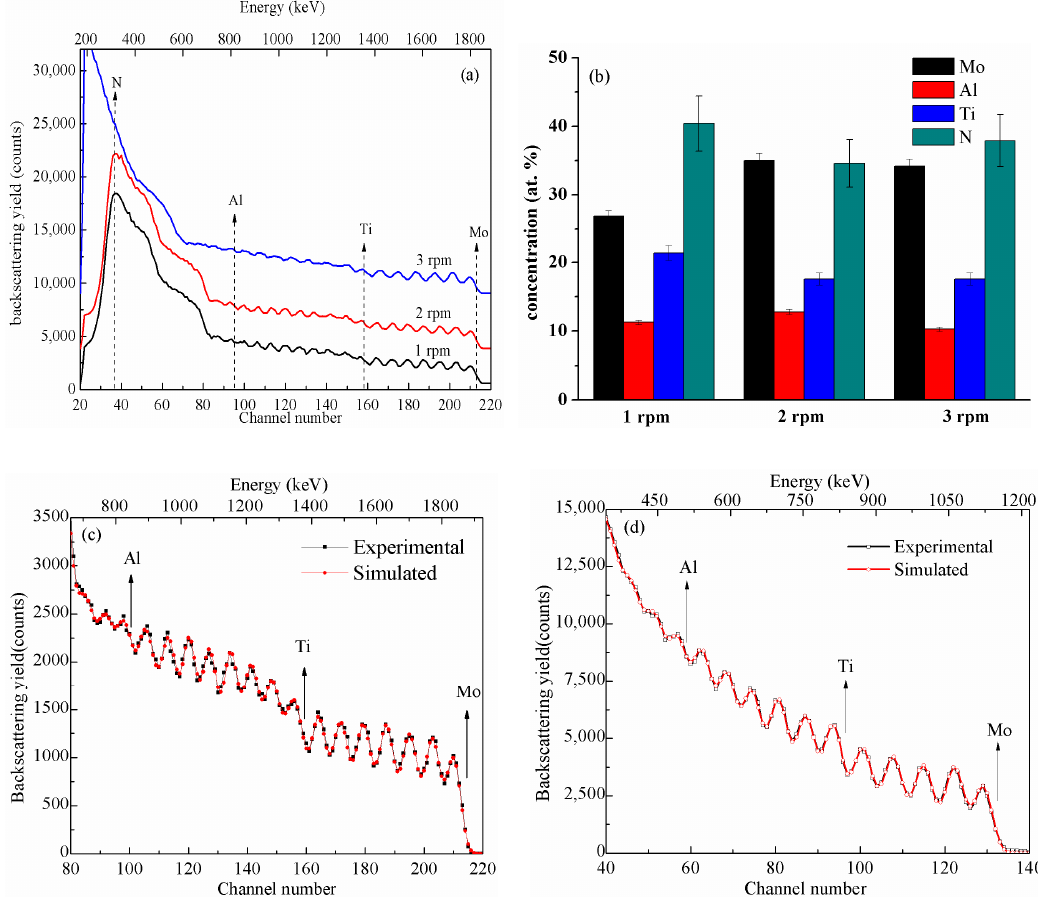
Figure 8. ( a ) RBS spectra using an incident 7 Li 2 + ion beam of 2.42 MeV and ( b ) corresponding atomic concentrations of Mo-Ti-Al-N coatings fabricated at 1, 2, and 3 rpm; Experimental and simulated RBS spectra of the coatings at 2 rpm with black solid dots and red lines showing experimental data and SIMNRA6.05 simulation results, respectively when the initial energy of incident 7 Li 2 + ion beam is ( c ) 2.42 MeV and ( d ) 1.52 MeV.